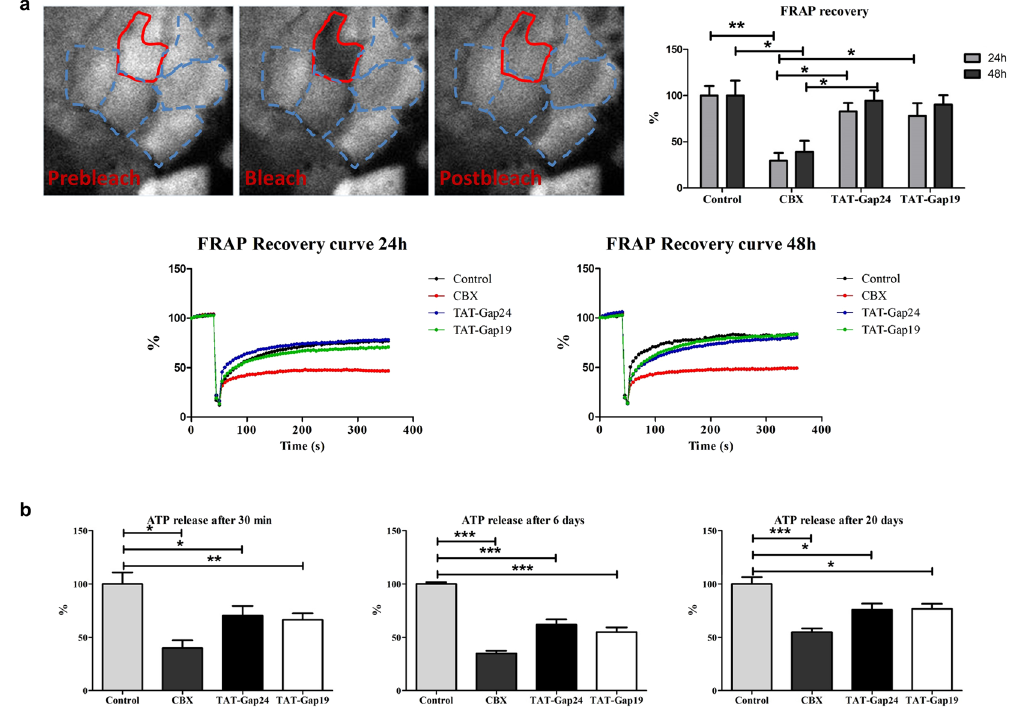
Figure 1. Effects of TAT-Gap24 and TAT-Gap19 on gap junction activity and connexin hemichannel responses. Primary rat hepatocytes were exposed to 50 µ M CBX, 20 µ M TAT-Gap24, 20 µ M TAT-Gap19 or vehicle control. ( a ) Gap junction activity measured through FRAP analysis after 24 h and 48 h (n = 4, N = 4). Fluorescence in the bleached cell was expressed as the percentage of recovery relative to the starting level just before photobleaching. A similar analysis was performed on cells distant from the bleached area to monitor photobleaching outside the targeted region. The recovery values for each experiment were normalized to the corresponding vehicle control condition. Pre-bleach (left panel), bleach (middle panel), post-bleach (right panel) after 6 min. ( b ) ATP release 30 min after incubation of TAT-Gap24, TAT-Gap19 or vehicle control for 0 min, 6 days and 20 days (n = 3, N = 6). Data are expressed as means ± SEM with * p < 0.5, ** p < 0.01 and *** p < 0.001.